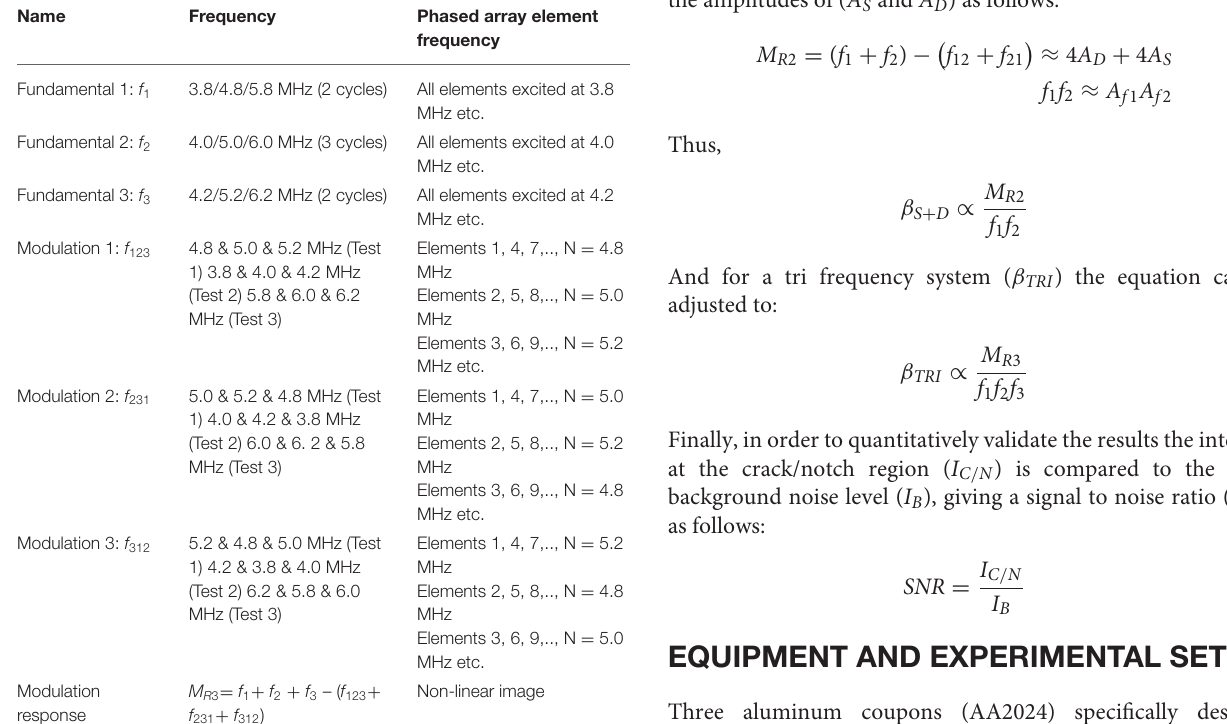
FIGURE 4 | Summary of tri frequency modulation calculation for M R 3 . TABLE 2 | Tri frequency modulation